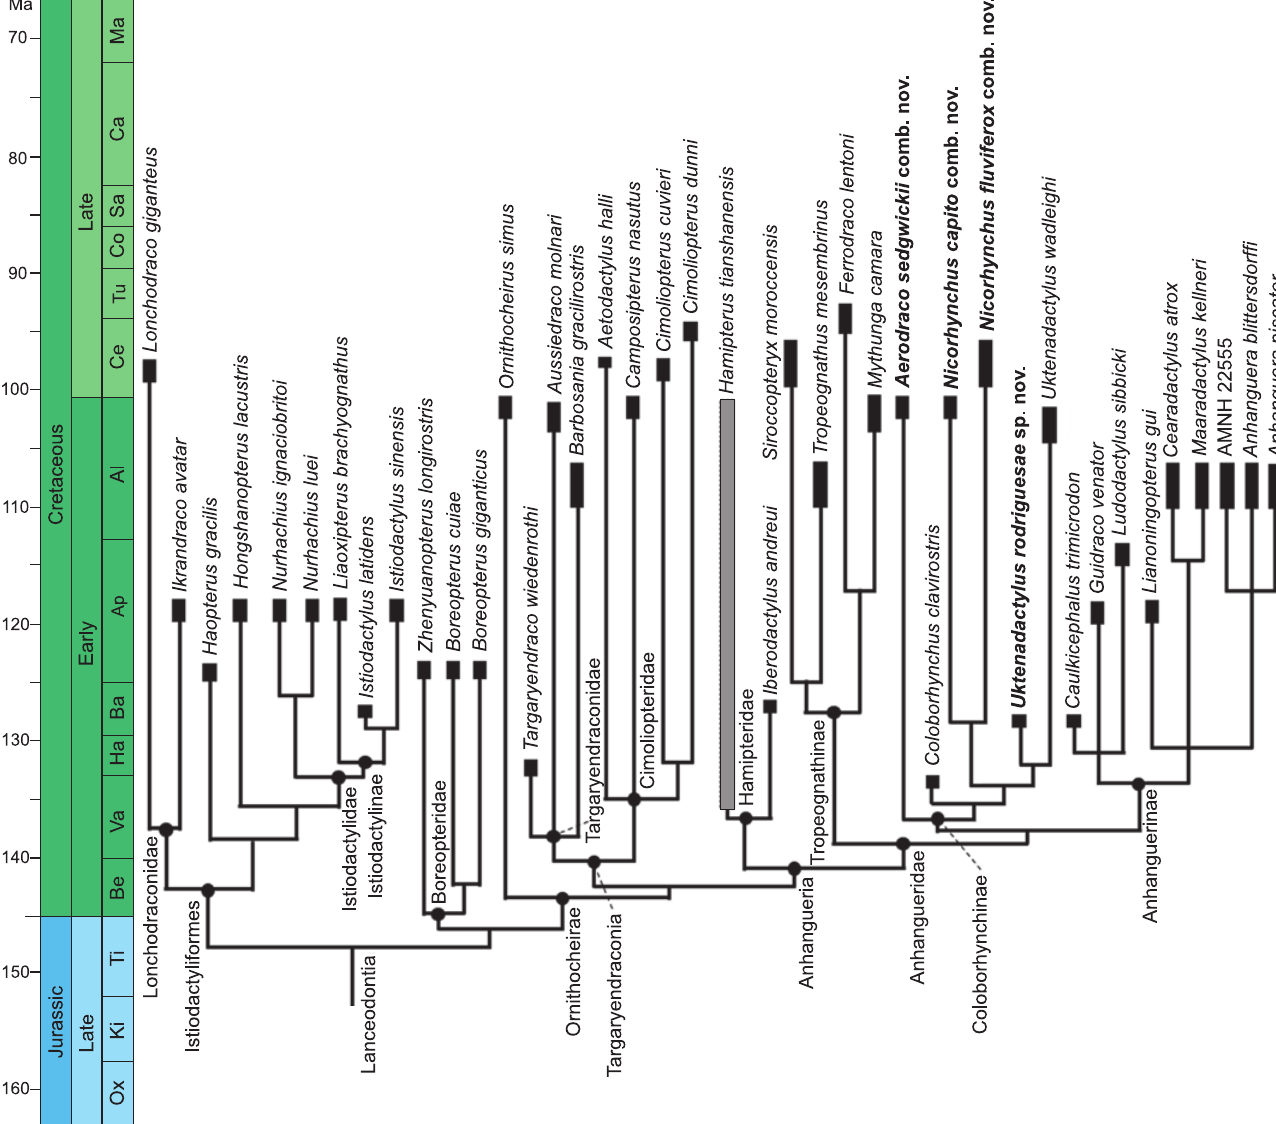
Fig. 10. Phylogenetic relationships of the Coloborhynchinae and Tropeognathinae clade nov. within Lanceodontia. Outgroup relationships are not shown (see SOM: fig. S3 for further details). Gray bar shows uncertain temporal range. Stratigraphic chart modified from Cohen et al. (2013). Drawing by BH. New taxa combinations and species proposed in this paper marked in bold. Abbreviations: Al, Albian; Ap, Aptian; Ba, Barrenian Be, Berriasian; Ca, Campanian; Ce, Cenomanian; Co, Coniacian; Ha, Hauteri vian; Ki, Kimmeridgian; Ma, Maastrichtian; Ox, Oxfordian; Sa, Santonian; Ti, Tithonian; Tu, Turonian; Va,